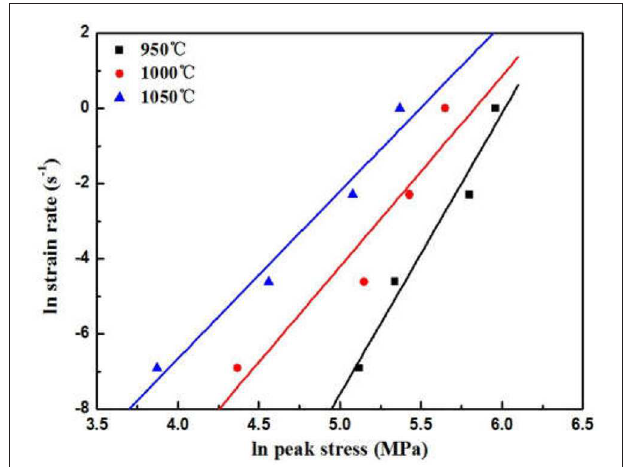
FIGURE 4 | Variation of the peak flow stress with temperatures and strain rates for the Ti-25.5Al-13.5Nb-2.8Mo-1.8Fe alloy.